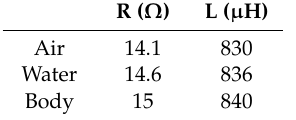
Table 3. Comparison of R and L values for the sensor wrapped around different materials. All measures were made at 100 kHz and with the same loop geometry.